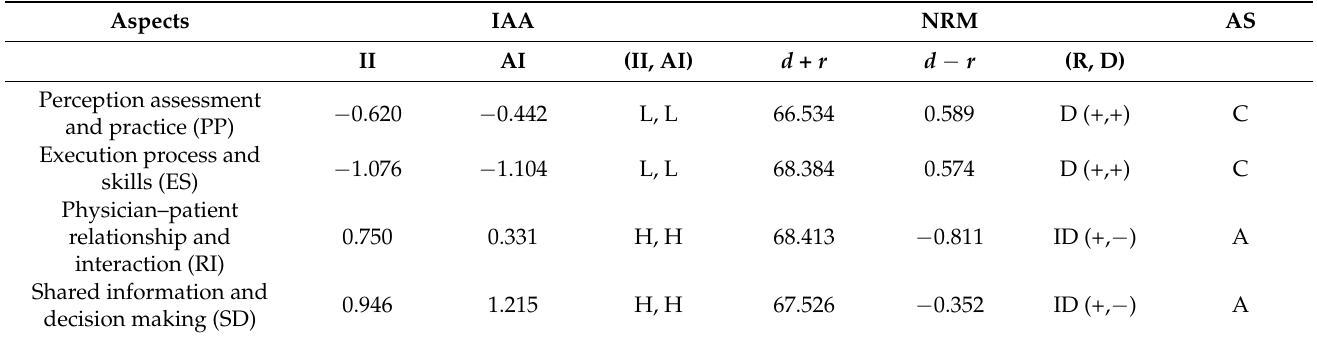
Table 8. The adoption strategy of SDM competency development for medical